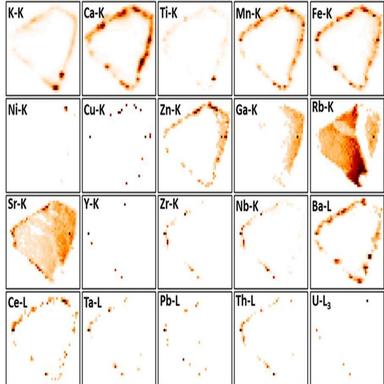
Confocal μ-XRF virtual cross section of the particle shown in This figure shows a virtual cross section of the sample, where most elements are visible on the edge only, and only a few show a detectable internal distribution (Rb, Sr). Map size 1150 � 950 μm2 , stepsize 25 μm, 8 s per pixel.